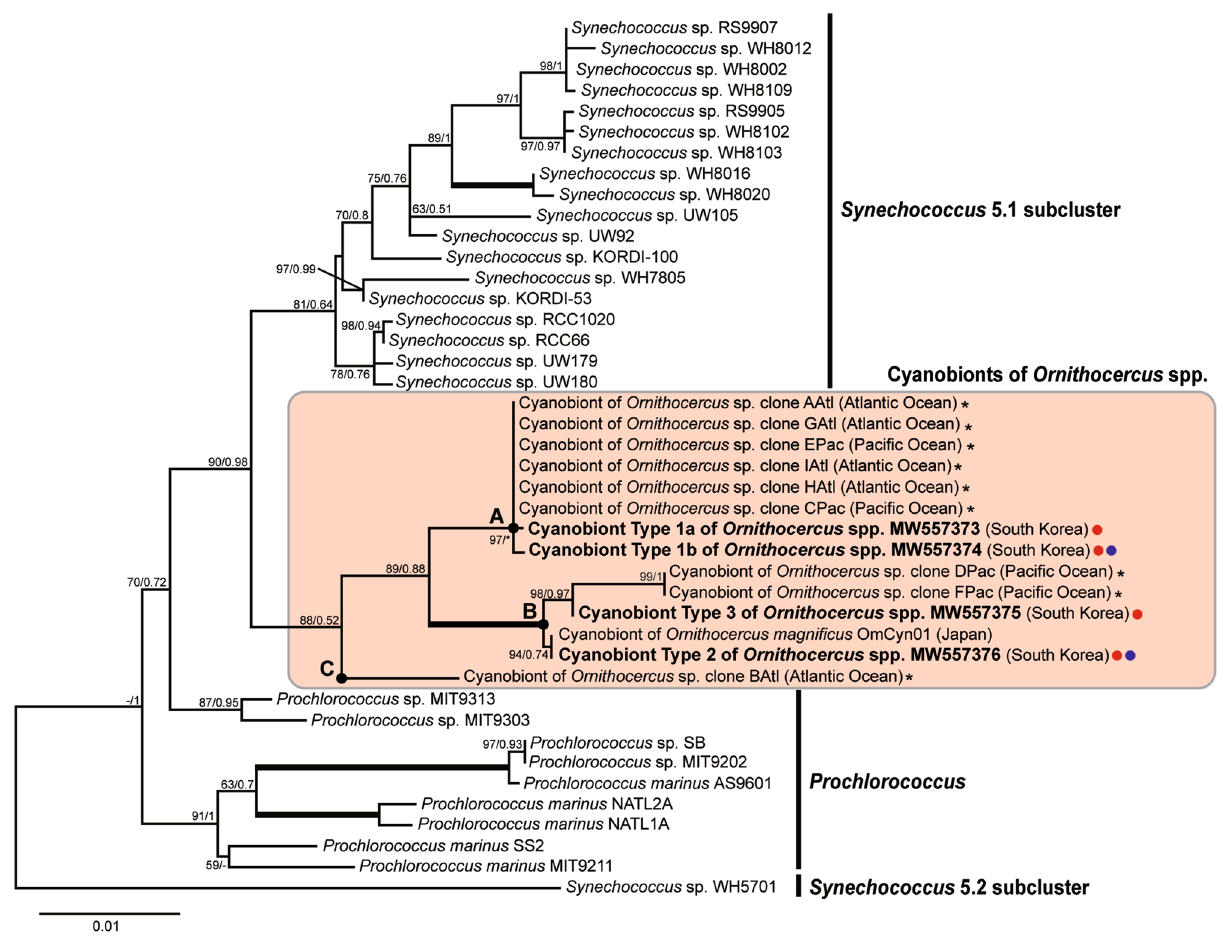
Figure 3. The Maximum Likelihood (ML) phylogeny of cyanobacterial symbionts (cyanobionts) from a dinoflagellate Ornithocercus host and marine picocyanobacteria based on combined data of the cyanobacterial partial 16S rDNA-entire ITS gene. Bold text indicates the Ornithocercus cyanobiont sequence obtained in this study. Red and blue circles represent amplified sequences from single-host DNA and single-cyanobiont DNA, respectively. The ML tree was inferred using IQ-TREE. Branch support was obtained from bootstrap values and a Bayesian posterior probability. A thick branch denotes a strongly supported bootstrap value of 100% and the highest posterior probability (1). The hyphen represents the unmatched tree topology with the Bayesian tree. Letters on branches ( A – C ) refer to clades of Ornithocercus cyanobionts. Asterisks represent the taxa of which only short 16S rDNA sequences (V3–V4 regions) were analyzed. The letters in parentheses indicate the geographic origins of the Ornithocercus cyanobionts. The scale bar represents the substitution per site.